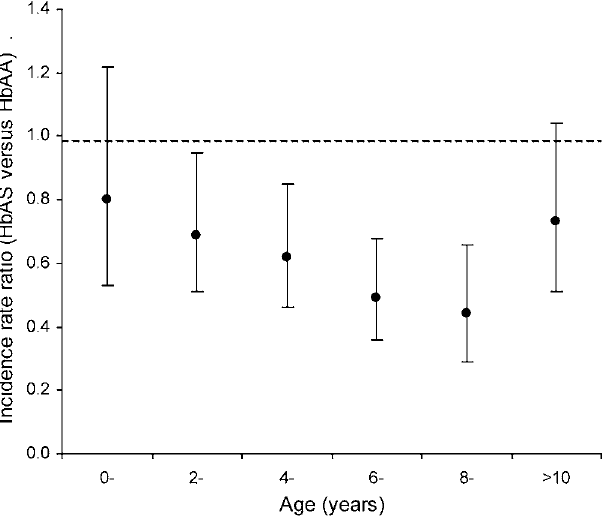
Figure 1. The IRR for Malaria in HbAS versus HbAA Children by Age and Genotypic Group Infants less than 3 mo old were excluded from the baseline group. DOI: 10.1371/journal.pmed.0020128.g001